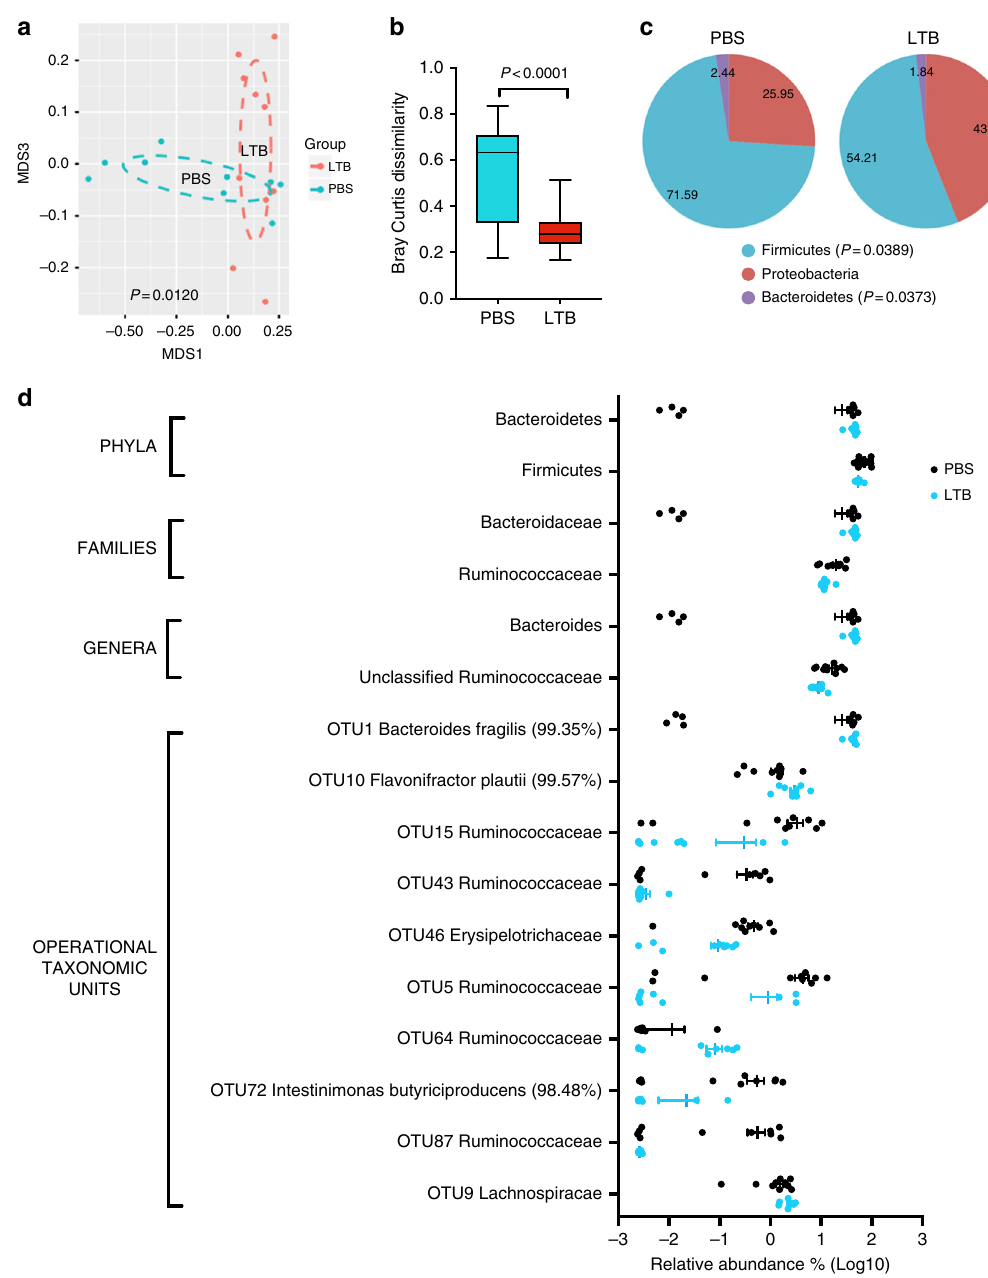
Fig. 7 AB 5 toxins cause shifts in the gut microbiome of chickens by affecting diversity and composition. a NMDS plot based on Bray Curtis distances show that introduction of heat-labile enterotoxin (LTB, n = 9) causes a signi fi cant shift ( p = 0.0120, Adonis PERMANOVA test) in the gut microbiome of chickens relative to chickens treated with PBS ( n = 10). b Although α -diversity is not affected, LTB decreases β -diversity ( p < 0.0001, two-tailed unpaired t -test with Welch ’ s correction) indicating that the toxin lowers inter-individuality of the gut microbiota. c LTB decreases the relative abundance of Firmicutes ( p = 0.0389) with parallel increases in Bacteroidetes ( p = 0.0373). d Signi fi cant changes in relative abundance (expressed as log 10 ) at selected taxonomic level (see Table 2 for p -values and percentages of relative abundance). Whiskers in b represent minimum and maximum values. Lines and bars in d represent means and standard error of means. Source data are provided as a Source Data fi